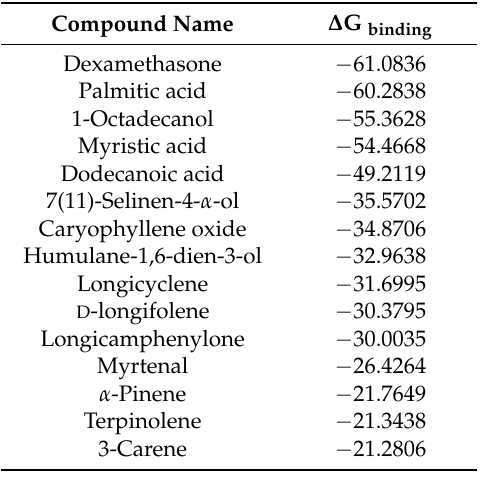
Table 4. Binding of the major PRO components to human glucocorticoid receptor (GR) using molecular modeling experiments as manifested by binding energy values ( ∆ G binding ) expressed in